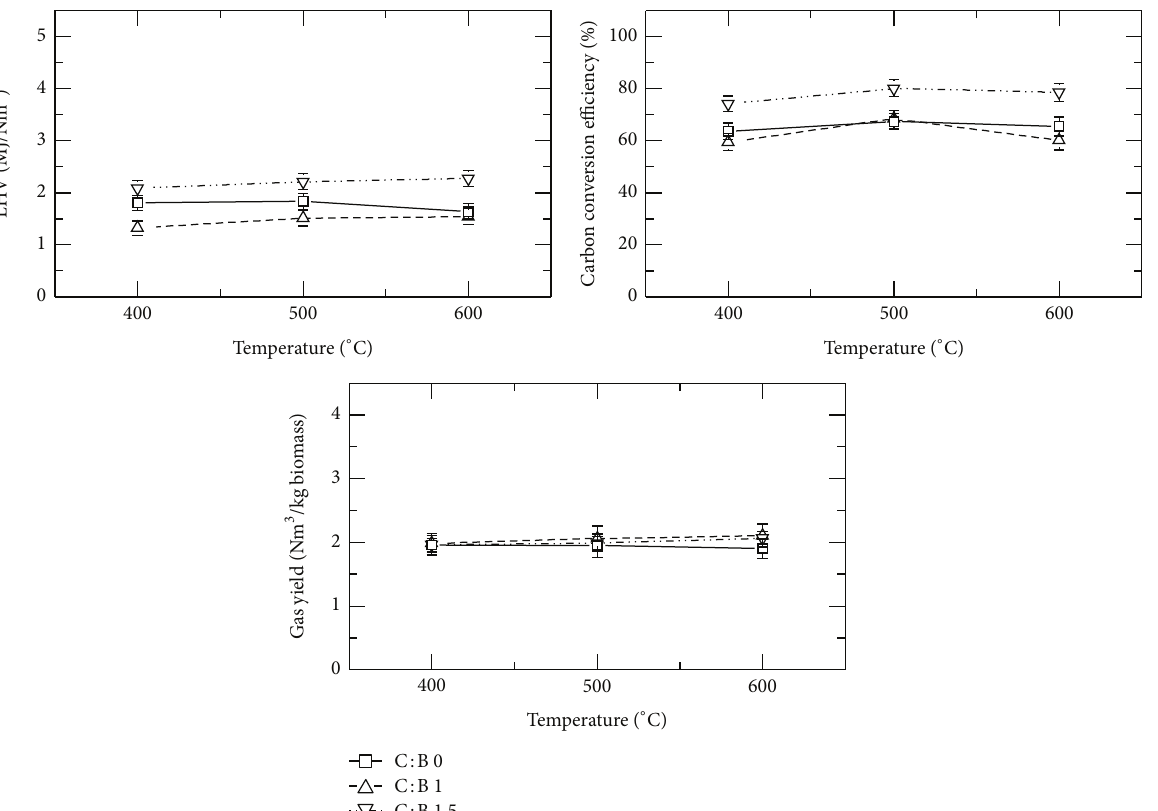
Figure 5: Effect of catalyst ratio on LHV, carbon conversion efficiency, and gas yield at different